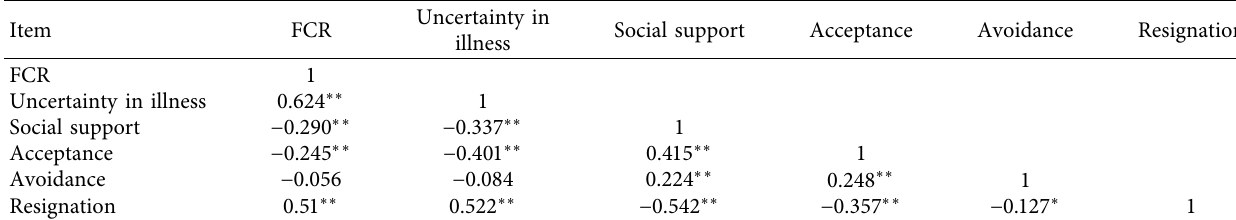
Table 3: Correlation analysis between FCR and uncertainty in illness, social support, and coping styles in breast cancer patients.